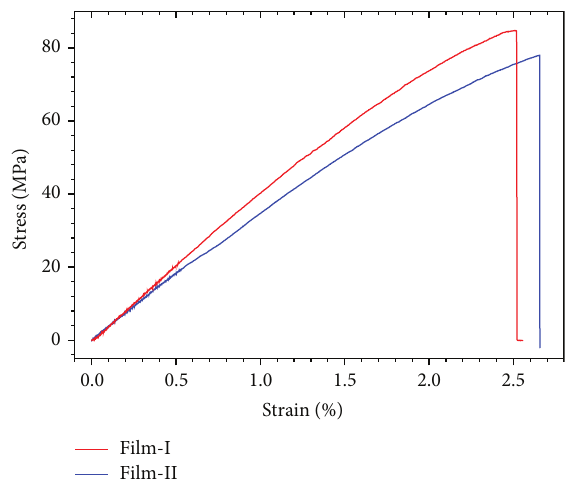
Figure 3: The typical stress-strain curves of the films under uniaxial tension.